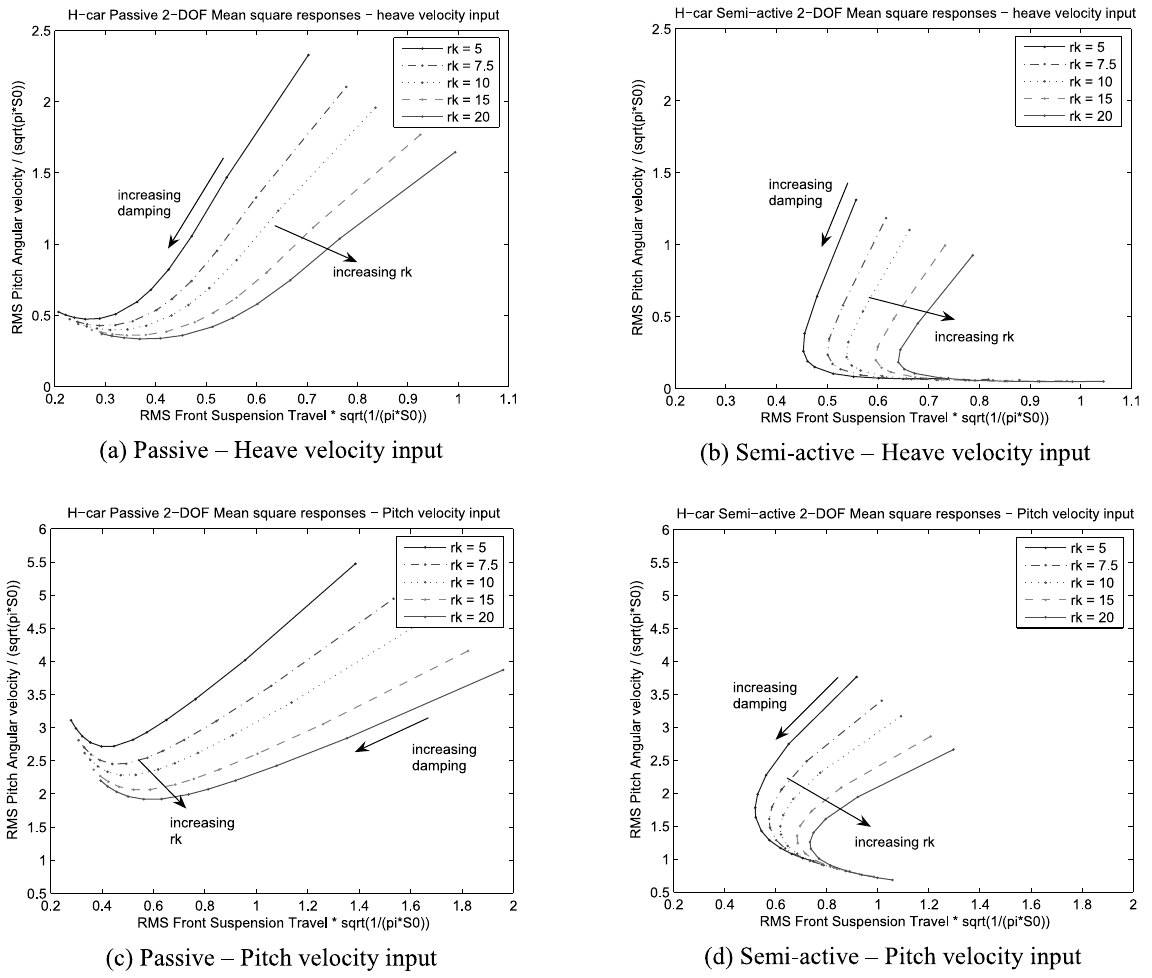
Fig. 10. Relationship between the rms pitch angular velocity to rms front suspension